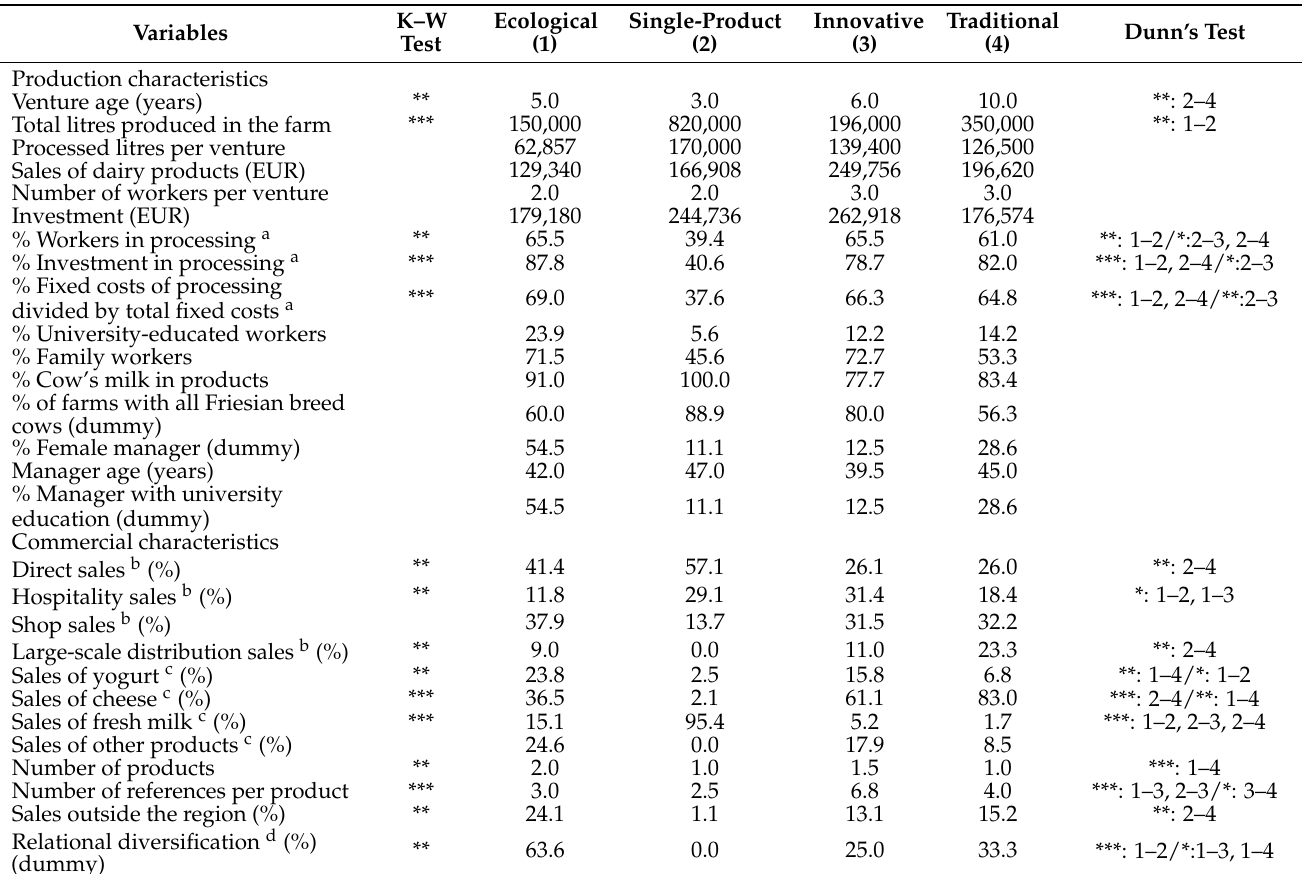
Table 5. Production and commercial characteristics of the value-creating strategies.